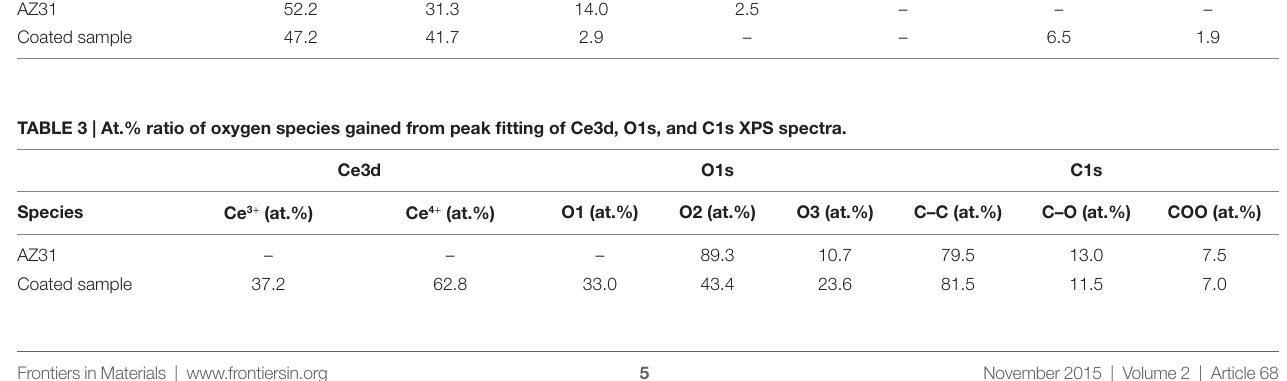
TaBle 2 | elemental composition gained from XPs survey spectra. c (at.%) O (at.%) Mg (at.%) al (at.%) Zn (at.%) ce (at.%) n (at.%)